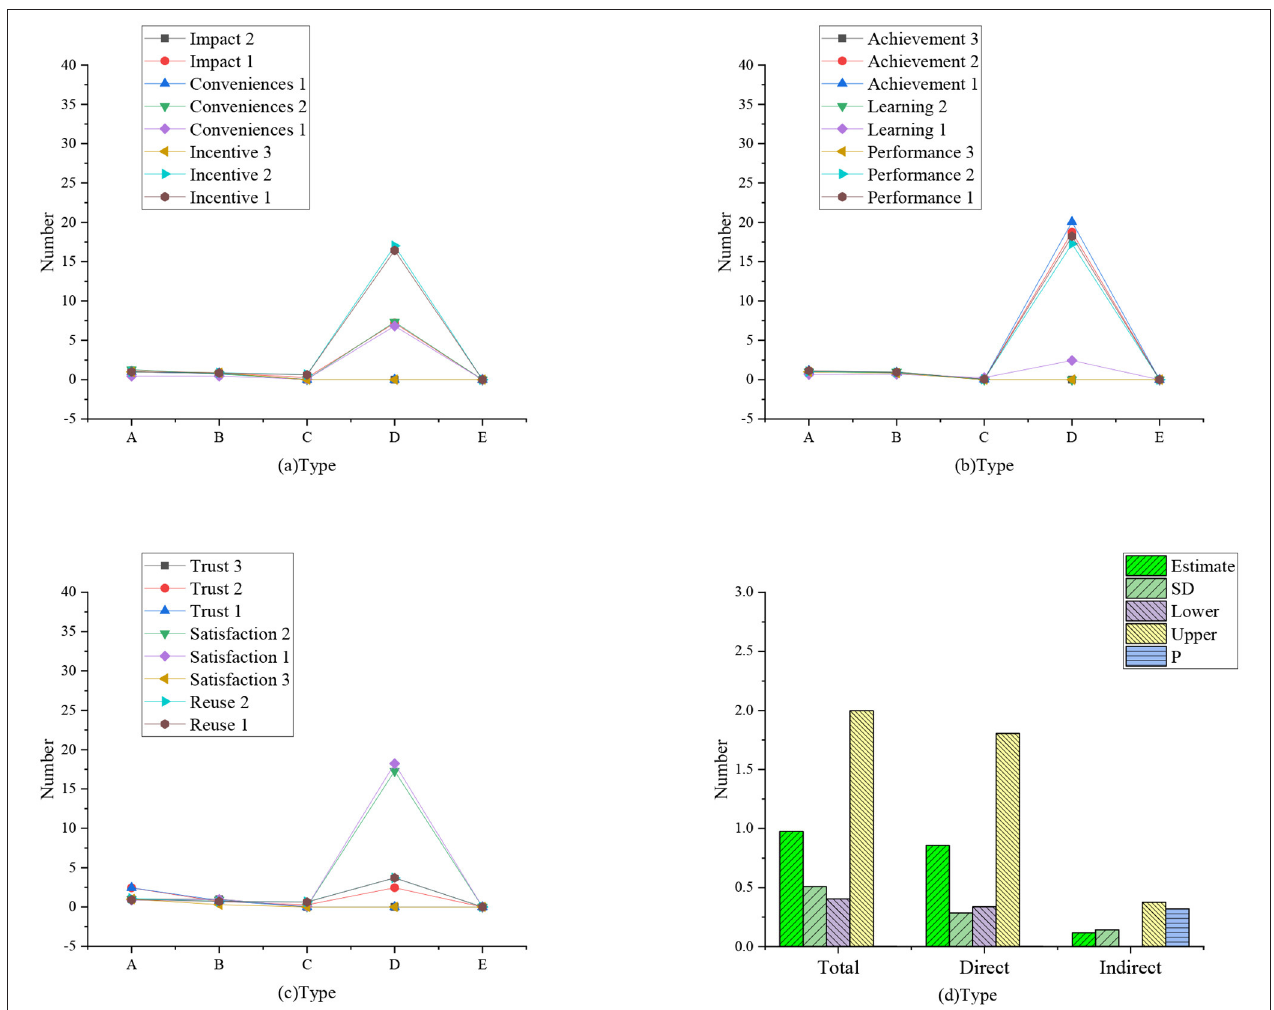
FIGURE 7 | Employee regression weight ( a : regression weight of influencing, incentive, and convenience factors; b : regression weight of learning, performance, and achievement factors; c : regression weight of trust, satisfaction, and reuse factors; d : mediation analysis conducted by enterprise administrator; A: non-standard; B: standardized C: SE value; D: T -value; E: P